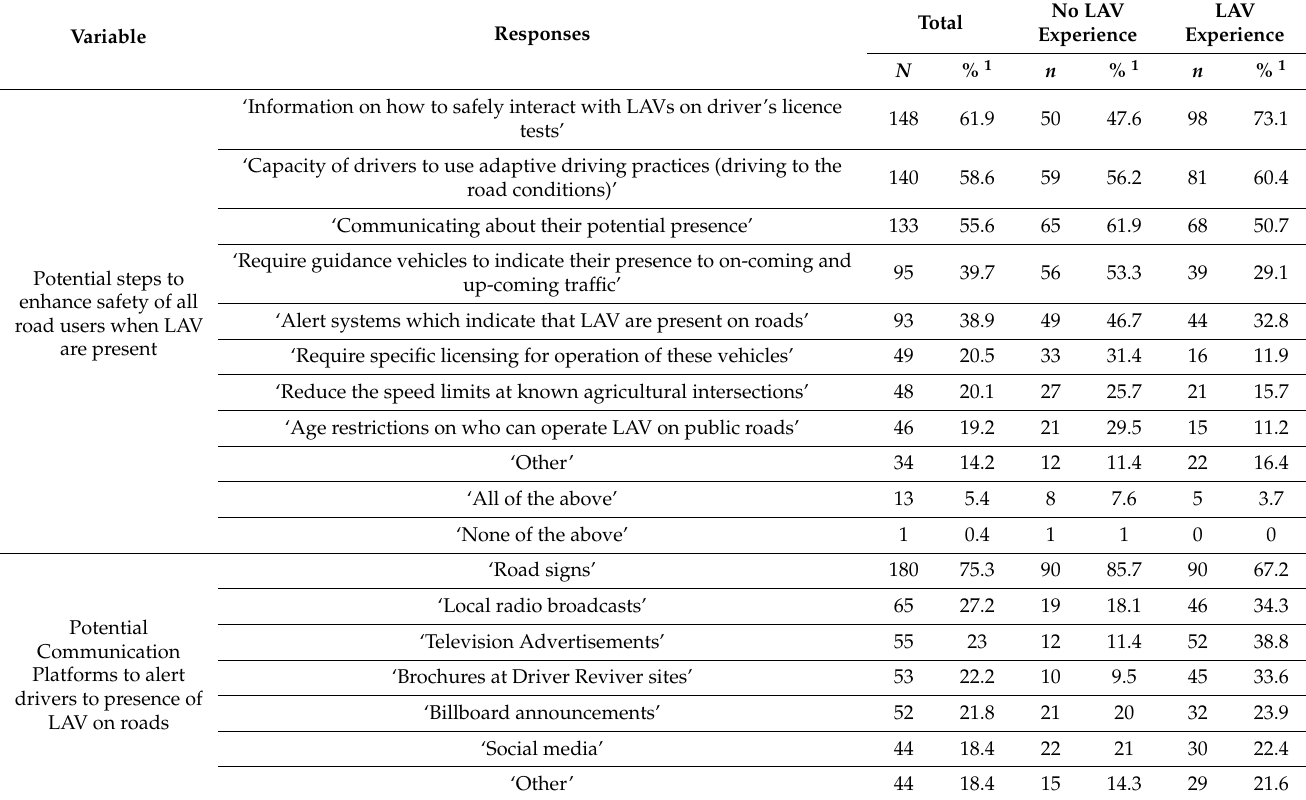
Table 5. Prevention and awareness-raising